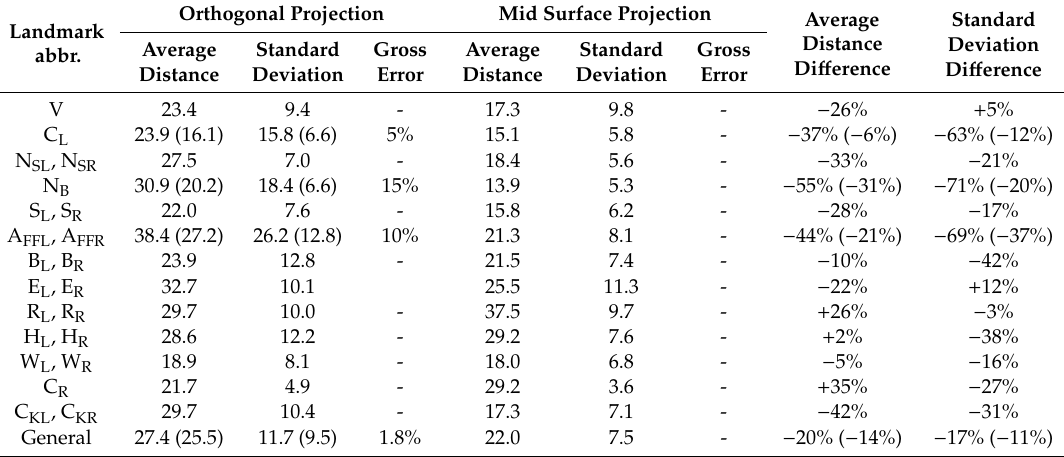
Table 2. Experimental results expressed in mm. Scores of the orthogonal projection were divided into the raw distances and filtered gross error values (presented in parentheses if applicable). Landmark abbr.